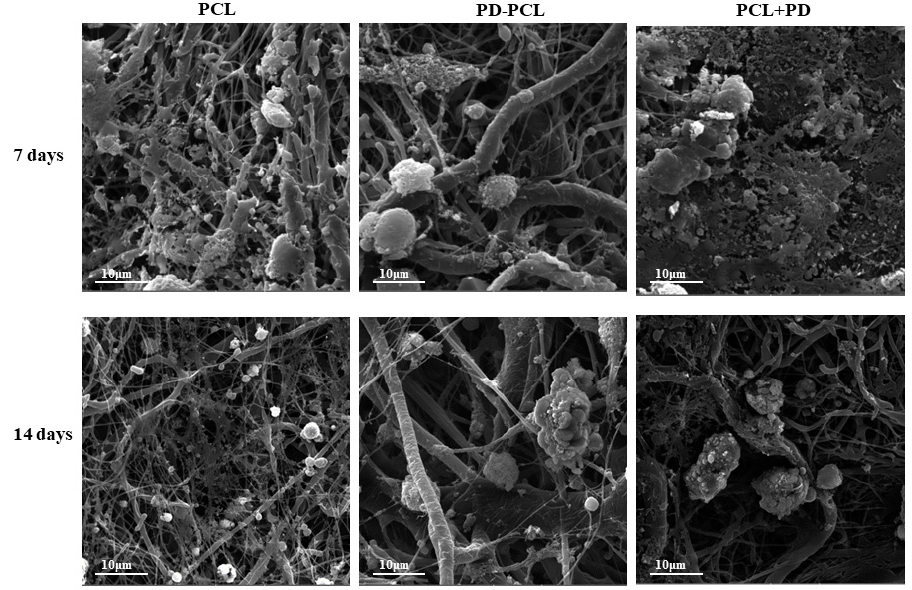
Figure 5. SEM Images of MSC cells grown for 7 and 14 days on: polycaprolactone scaffolds (PCL); PD-coated polycaprolactone scaffolds (PD-PCL); PCL scaffold with 48 µM PD added to the medium (PCL + PD).